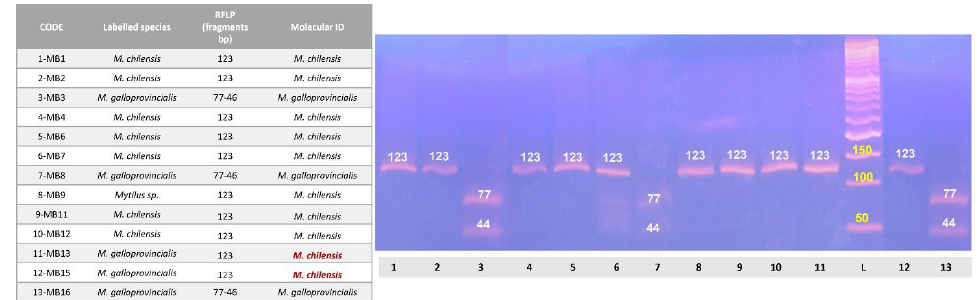
Figure 3. Results of PCR–RFLP analysis on DNA samples extracted from the 13 MB Mytilus sp. products. Electrophoretic run shows post Aci–I digestion outcomes on PCR products of PAP target according to Giusti et al. [21] protocol. The length (bp) of the fragments is reported above the bands. L—ladder .